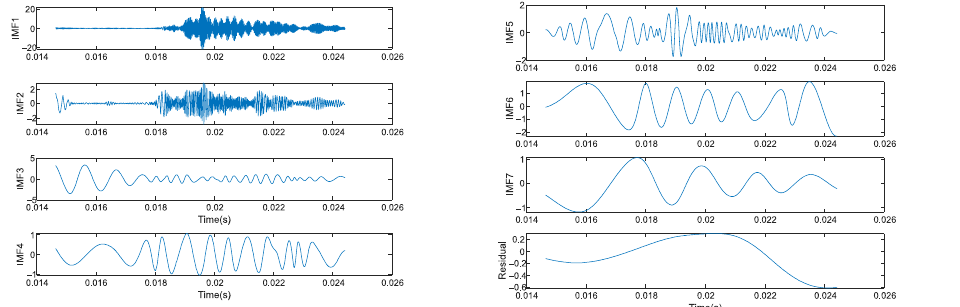
Figure 21. The IEMD waveform of intercept signal.